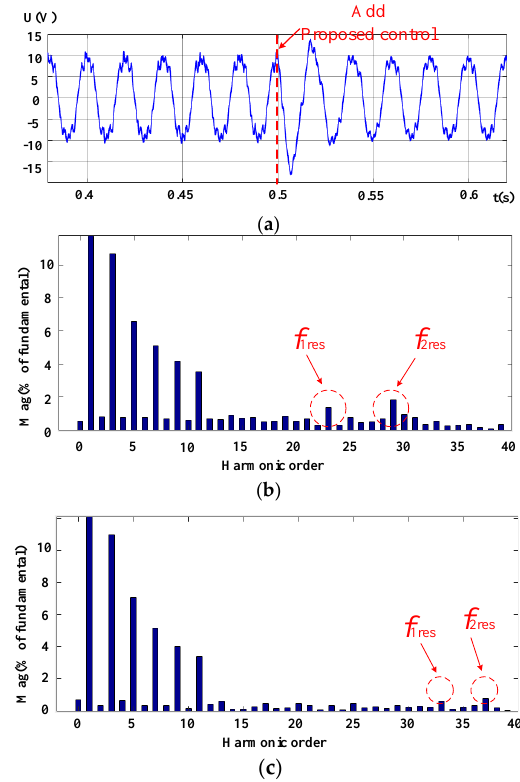
Figure 21. Output current of HCGI and its THD analysis. ( a ) Output current of HCGI ; ( b ) THD before t = 0.5 s (fundamental component = 9.851 A, THD = 16.56%); ( c ) THD after t = 0.5 s (fundamental component = 9.762 A, THD = 15.97%).